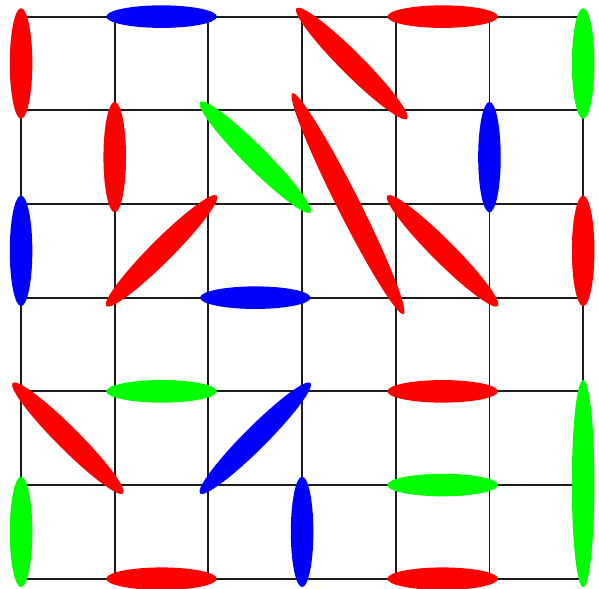
Figure 2: A typical VB covering of the 3-color RVB state whose amplitude depends both on the singlet covering and on the coloring